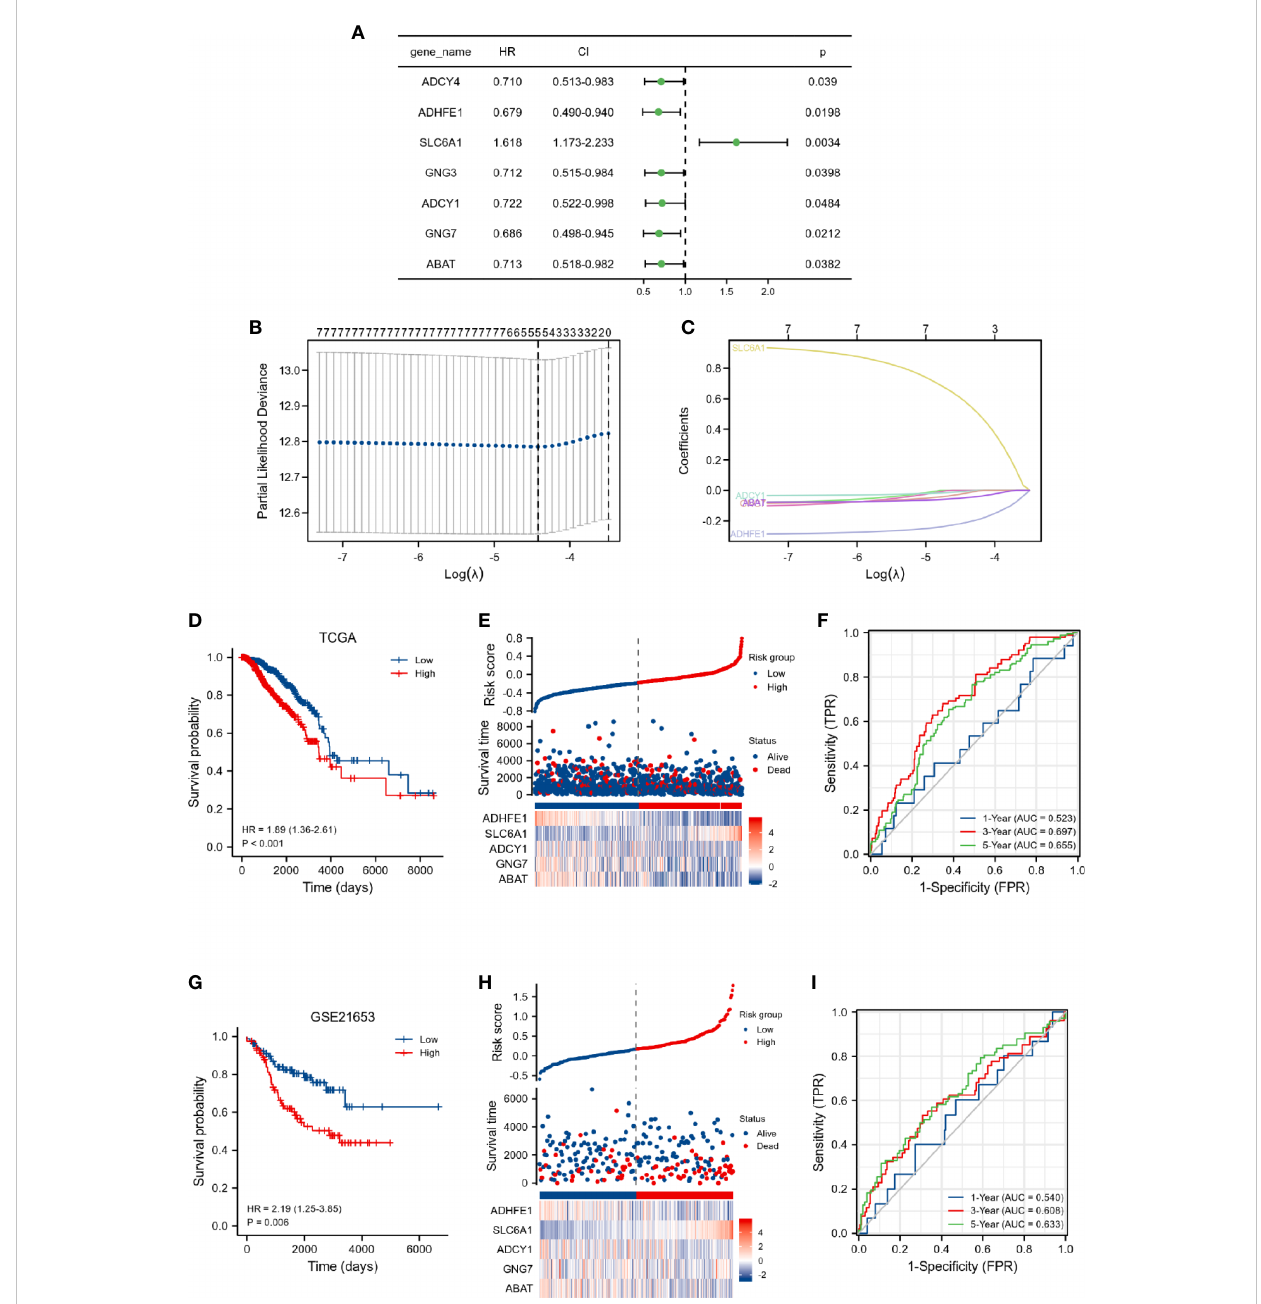
FIGURE 2 Construction of DEGRGs-related risk score model in TCGA dataset. (A) Univariate Cox regression analysis of DEGRGs. (B, C) LASSO regression analysis of 7 overall survival-related DEGRGs. (D) Kaplan-Meier survival analysis of risk score in the TCGA. (E) The expression level of DEGRGs (below), survival status (middle), and the distribution of risk scores in the low- and high-risk score groups (upper). (F) Time-dependent ROC curve analyses. Validation of DEGRGs-related risk score model in GSE21653 dataset. (G) Kaplan-Meier survival analysis of risk score in the GSE21653. (H) The expression level of DEGRGs (below), survival status (middle), and the distribution of risk scores in the low- and high-risk score groups (upper). (I) Time-dependent ROC curve